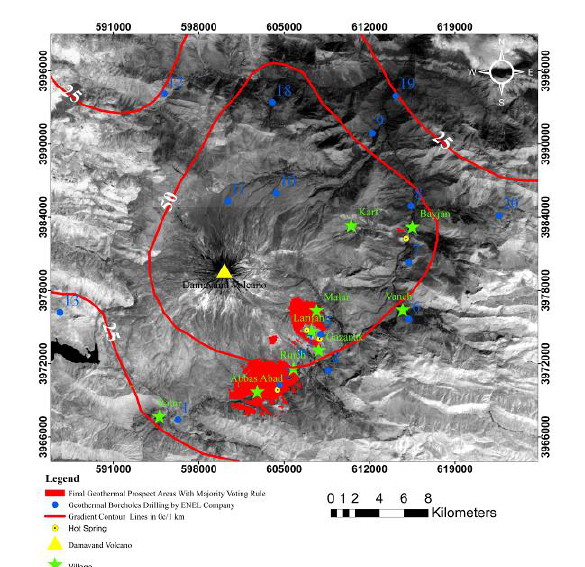
Figure 11. Comparison of final potential regions with thermal gradient from the